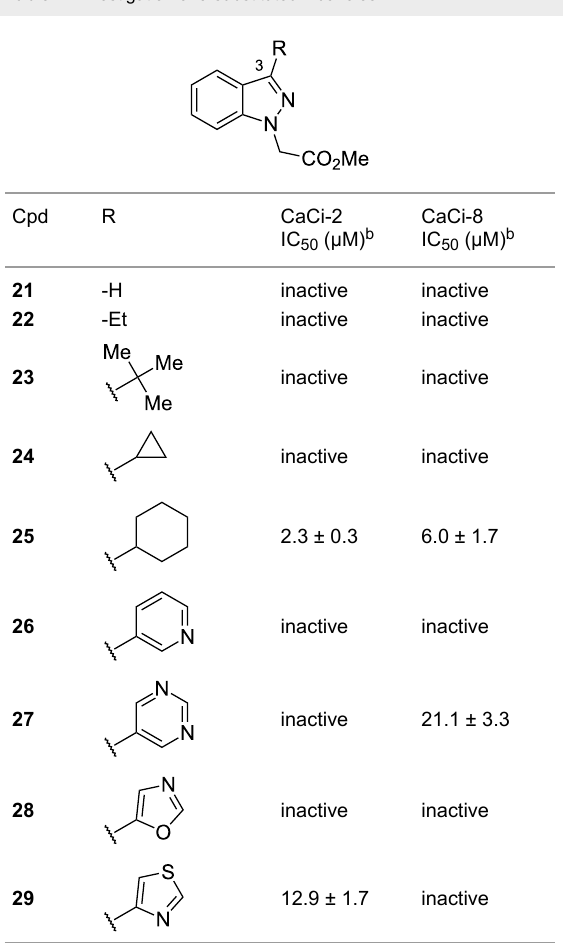
Table 2: Investigation of 3-substituted indazoles. a Table 3: Substituent effects associated with the 3-phenyl ring.